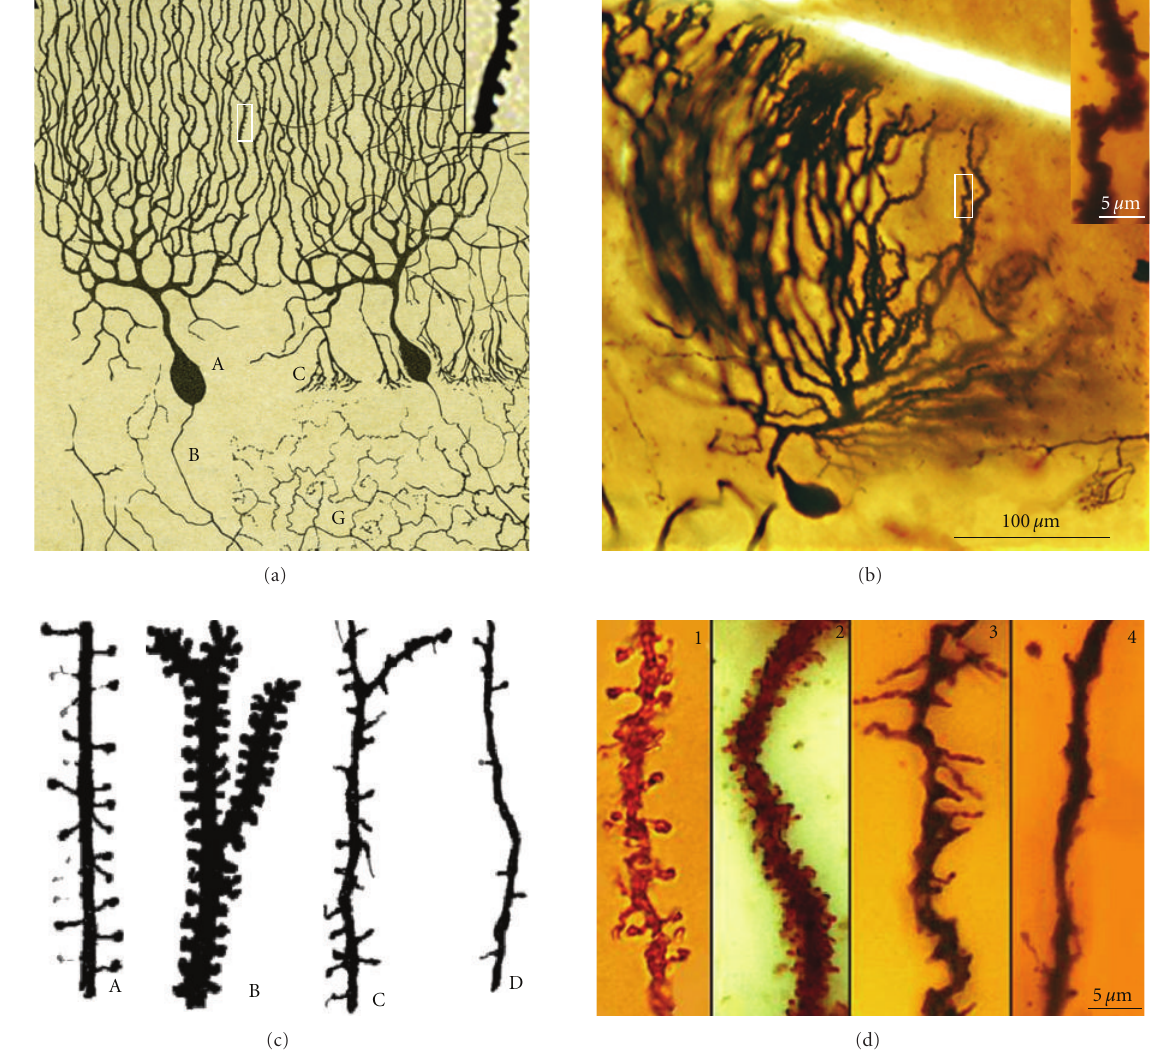
Figure 1: (a)Represents the first Cajal scientific drawing showingdendritic spines from a Purkinje cell of the hen, 1888. Inset showsdendritic spines digitally enlarged of the boxed region. (b) Purkinje cell and dendritic spines (inset) of the adult bird cerebellum taken from a Cajal’s histological preparation stained following the Golgi method. (c) drawing by Cajal [5] showing dendritic spines of pyramidal (A), Purkinje (B), basket (C) and Golgi cells (D). (d) dendritic spines and filopodia taken from Cajal histological preparations, and Golgi impregnation; 1, dendritic spines, pyramidal cell, parietal cortex, one-month-old human; 2, dendritic spines, Purkinje cell, adult cat cerebellum; 3, dendritic filopodia and spines, basket cell, cerebellum, of 17-day-old dog; 4, Golgi cell dendrite, cerebellum, of 17-day-old